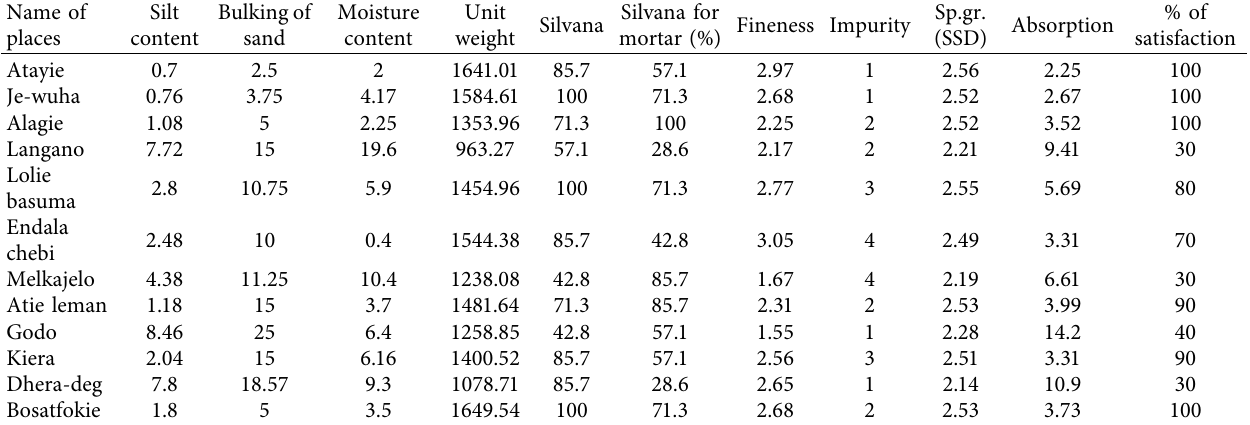
Table 5: Summary of experimental